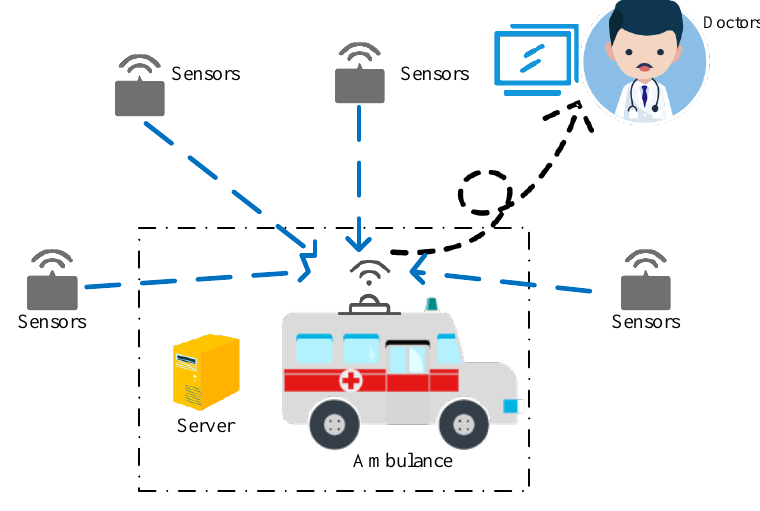
Figure 9. Architecture of IoT